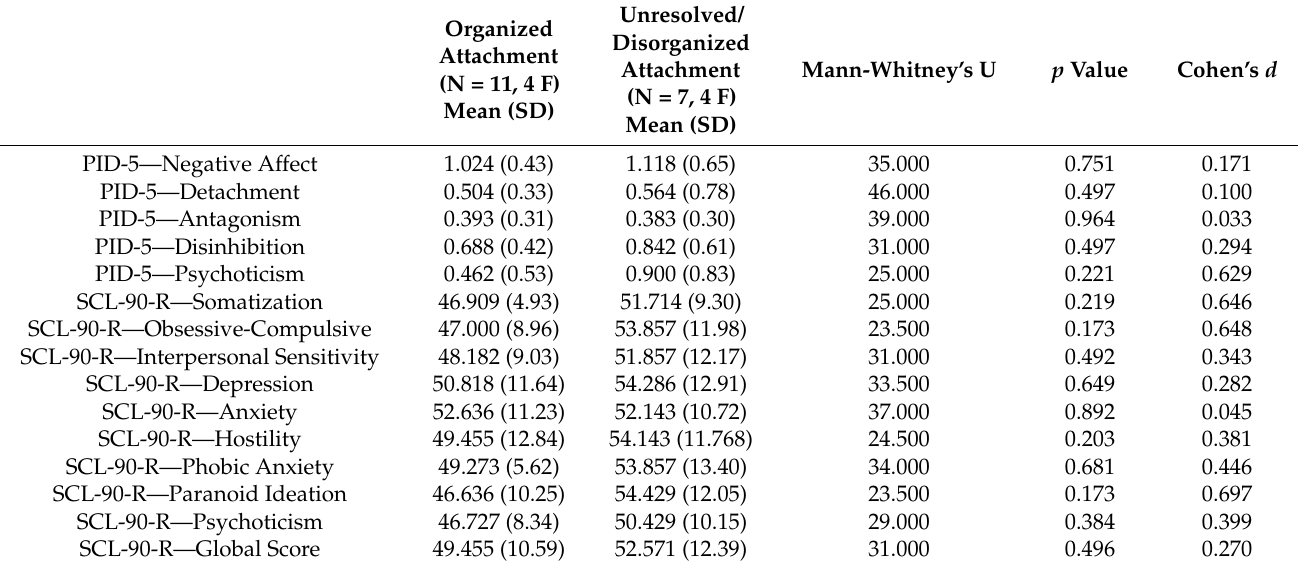
Table 1. Pre-existing group differences (means and standard deviations) in the clinical scales of the study.